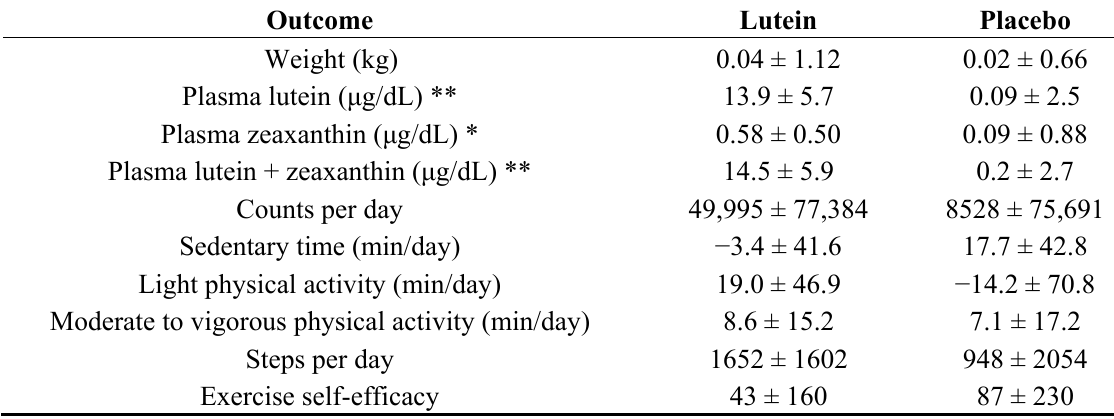
Table 2. Change in values following 4 weeks of supplementation and 3 weeks of physical activity participation.